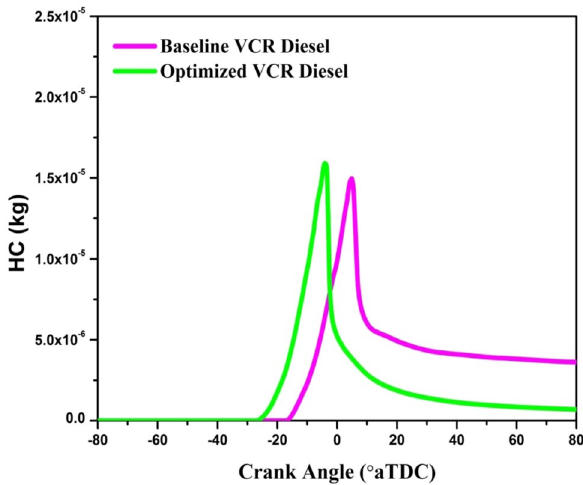
Fig. 10 Comparison of HC versus Crank Angle for baseline and optimized (VCR diesel)